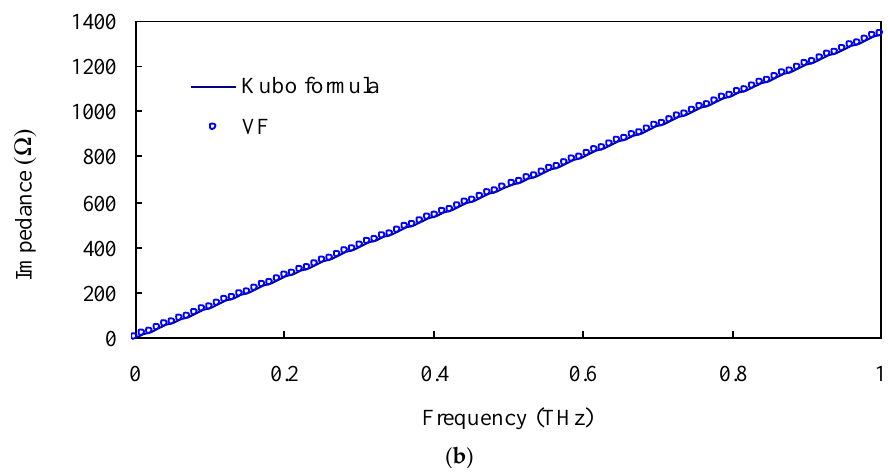
Figure 1. Graphene’s surface impedance: ( a ) real parts; ( b ) imaginary parts.